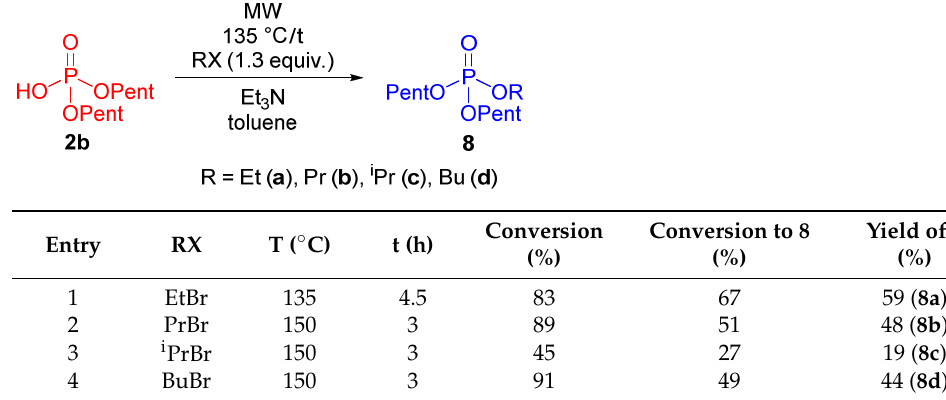
Table 5. Alkylating esterification of dipentylphosphate ( 2b ) with alcohols under MW conditions.